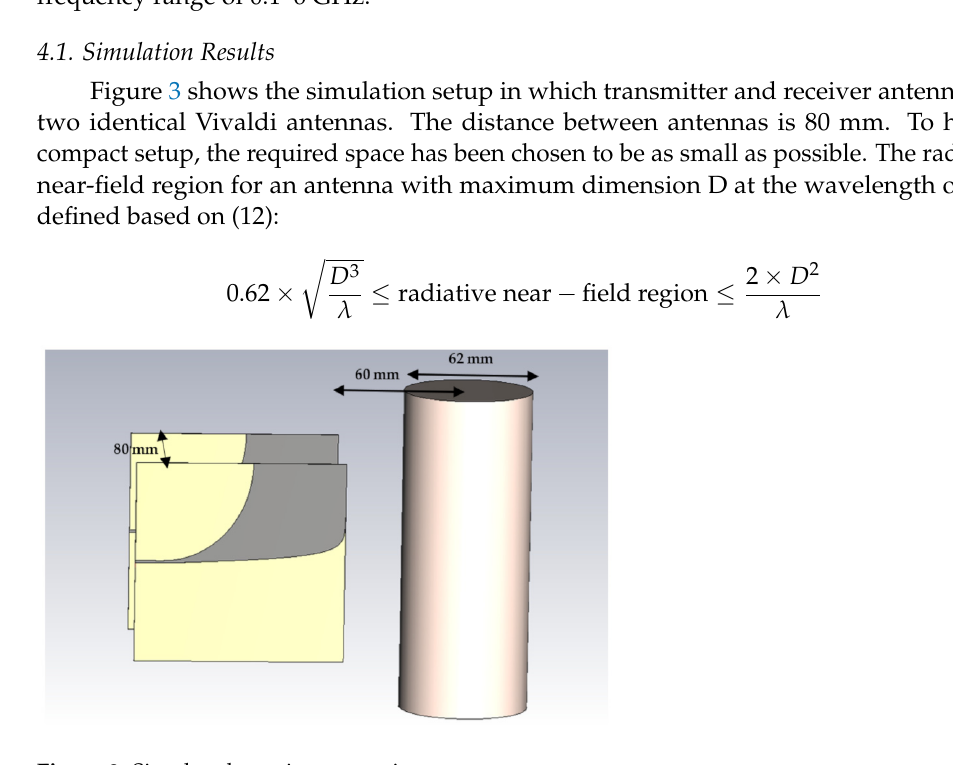
Figure 3. Simulated quasi-monostatic